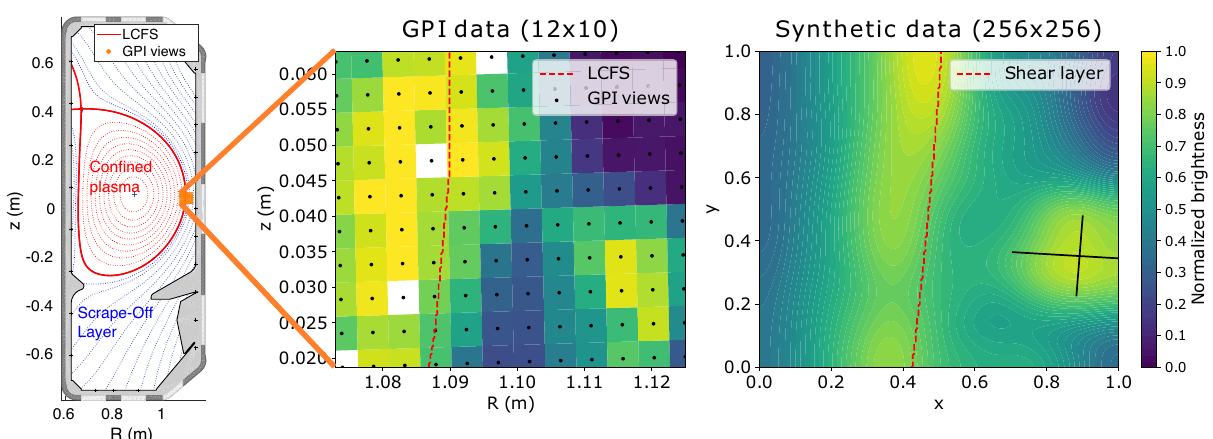
Figure 2. Cross-section of a plasma in the Tokamak à Configuration Variable (TCV) with the locations of Gas Puff Imaging (GPI) views near the Last Closed Flux Surface (LCFS) (left). Snapshot of experimental GPI data capturing a blob on the right-hand side moving radially outward (middle). Here empty (white) spots correspond to dead GPI views. The brightness level is coded in the color bar to the right, with low as blue and high as yellow. Snapshot of synthetic data capturing a blob moving radially outward (right). A Gaussian ellipse represents the blob with a major and minor axis marked by perpendicular black